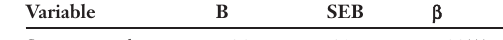
Backward elimination multiple regression analysis summary for variables predicting caregivers’ assess- ment of their parent- ing